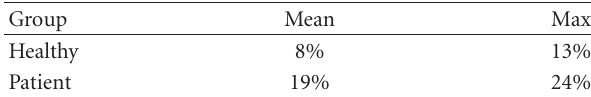
Table 2: Deviation from line y = x in Poincare